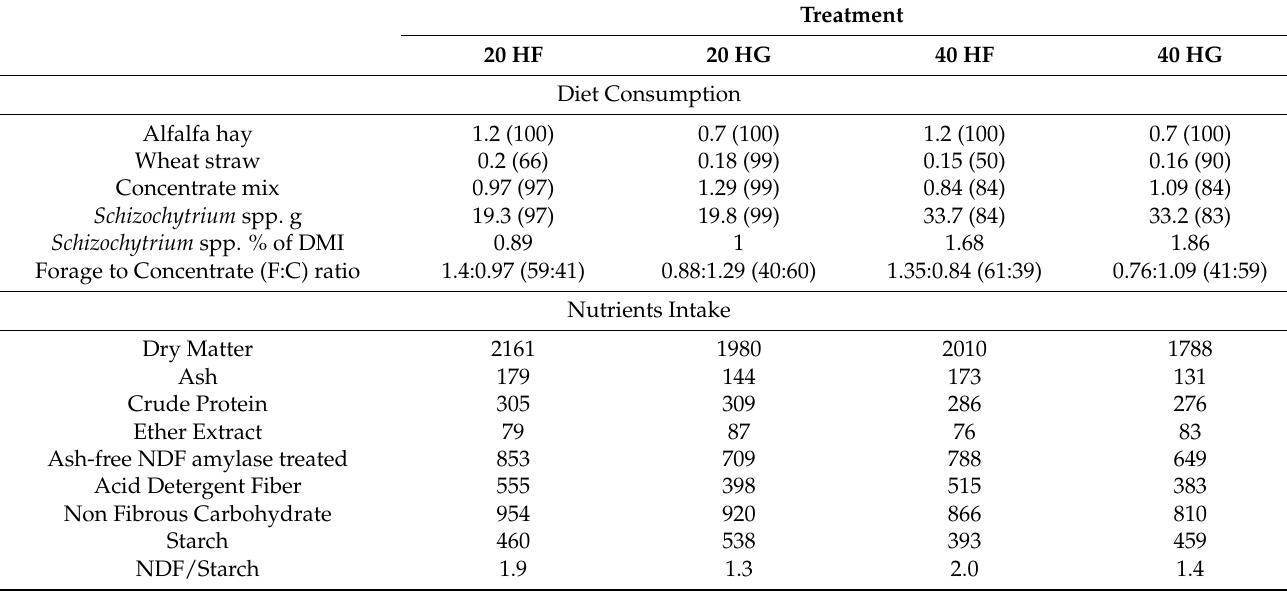
Table 3. Feed intake on a fresh matter basis (Kg/goat and percentage of the consumed quantities compared to given) and nutrients consumption (g) of the four groups (20 HF, 20 HG, 40 HF, and 40 HG) of goats involved in the